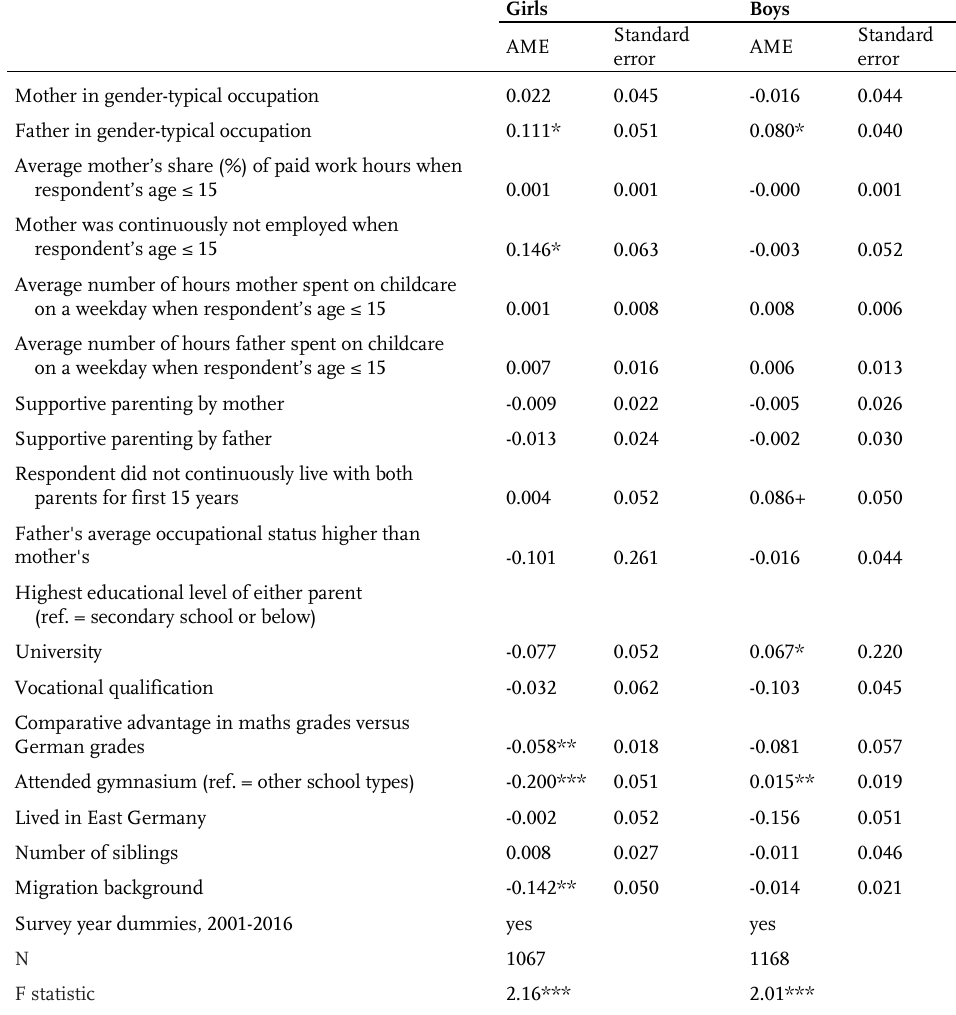
Table 2 : Average marginal effects based on logistic regression models of aspiring to a gender-typical